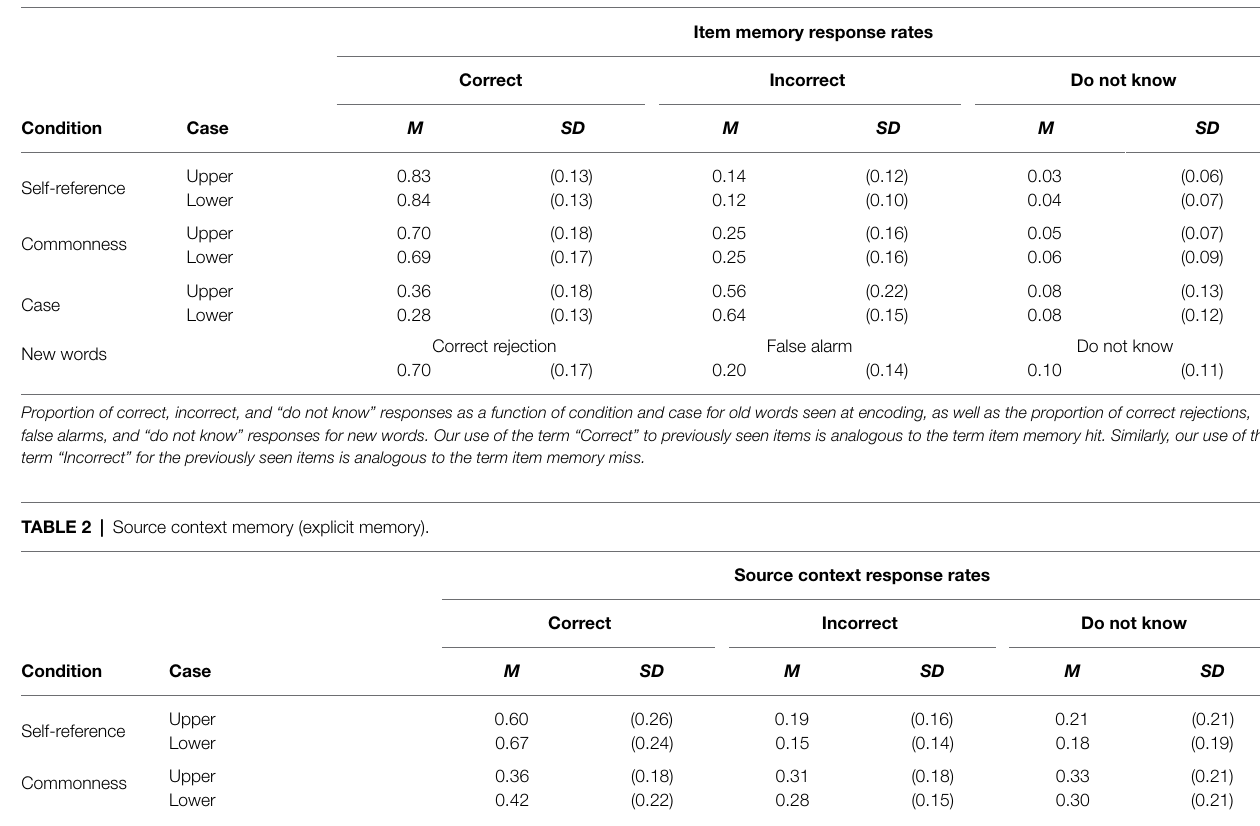
TABLE 1 | Item memory (explicit memory).